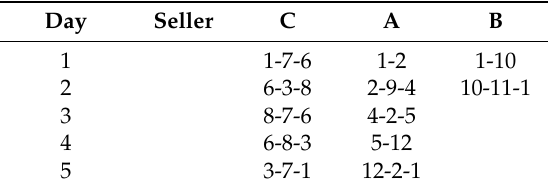
Table 3. Route results of Step 5.